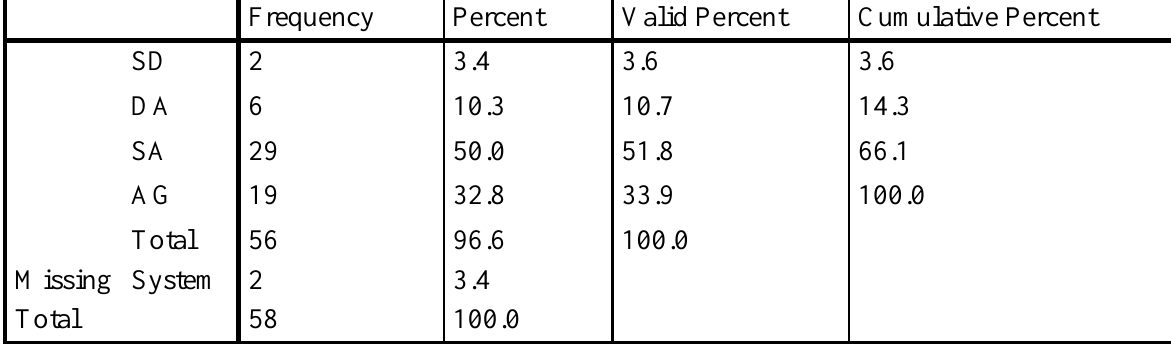
My personal affiliations distract me and I am unable to focus in my